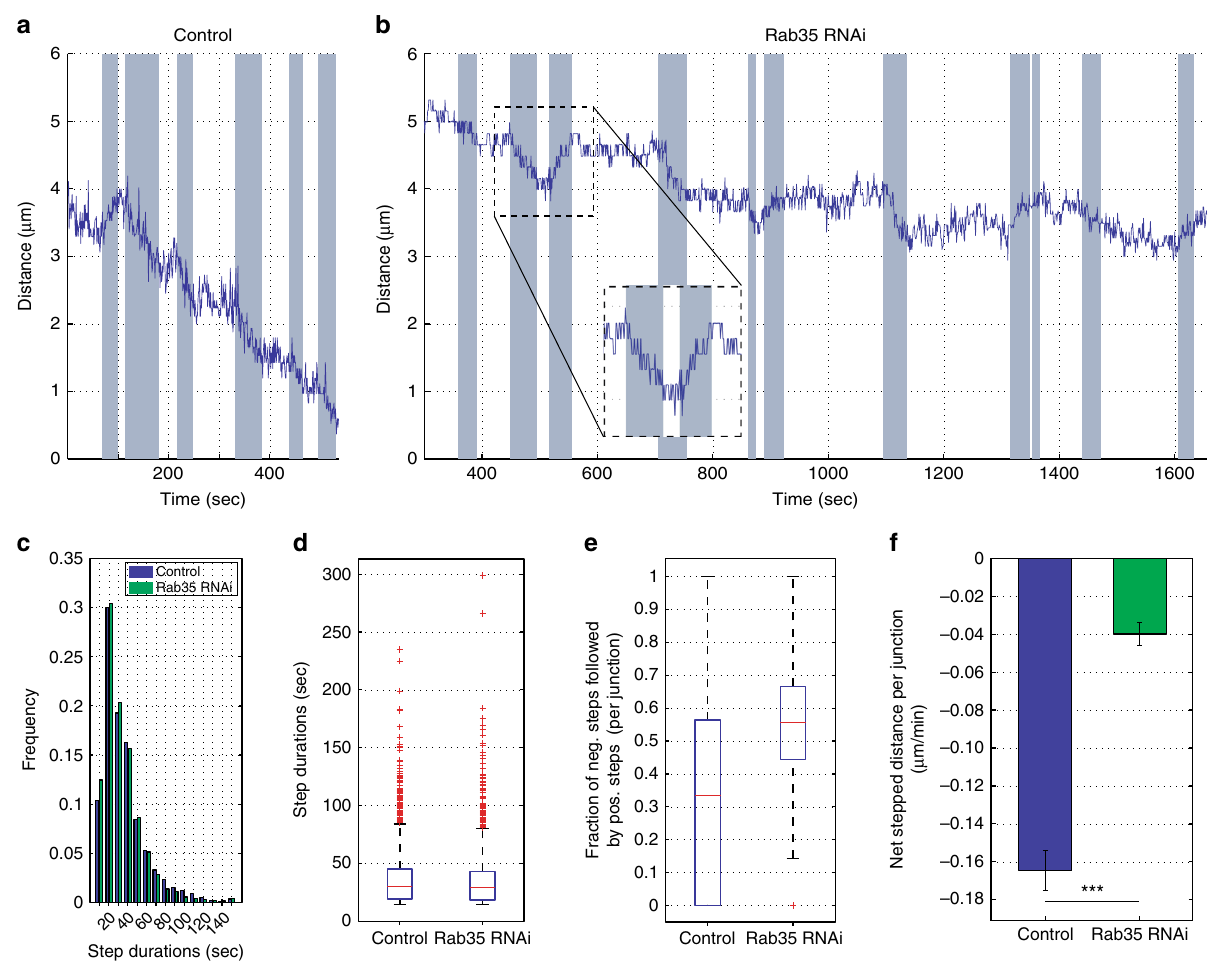
Fig. 3 Rab35 performs a ratcheting function during interface contraction. a , b Individual AP interface length plots in control Rh3 ( a ) and Rab35 dsRNA ( b ) embryos. Automated step detection indicates periods of active interface length change ( shaded regions ). A control interface progressively contracts within 8 min ( a ), while a Rab35 dsRNA interface undergoes active contractile steps followed by lengthening reversals ( b , inset ). After nearly 30 min, the AP interface is still preserved in Rab35 dsRNA embryo. c , d The frequency ( c ) and duration ( d ) of active stepping is similar in control and Rab35 dsRNA embryos. n = 2990 (control) and 2536 (Rab35 dsRNA) steps. e , f Contractile steps are often reversed by positive stepping in Rab35 dsRNA embryos ( e ) producing a decrease in net displacement ( f ). n = 328 (control) and 340 (Rab35 dsRNA) interfaces. Error bars indicate standard error. Student ’ s t